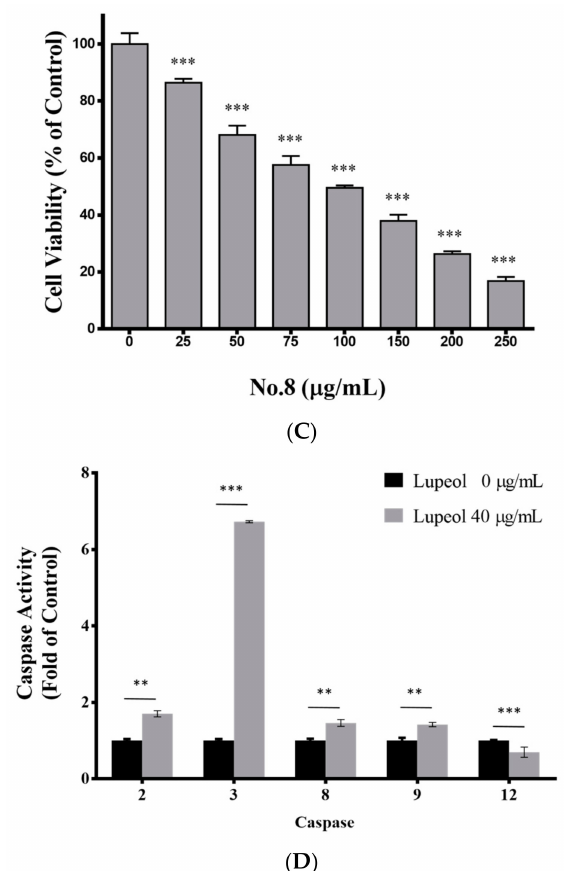
Figure 2. Apoptotic effect induced by AVL ( Apocynum venetum L.) F8 and lupeol on PC3 cells. ( A ) DAPI (4 (cid:48) ,6-diamidino-2-phenylindole) staining of AVL No. 8 or lupeol-treated PC3 cells; ( B ) flow cytometric analysis of propidium iodide staining was used to analyze apoptosis in PC3 cells following vehicle-treatment and 50, 100 µ g/mL for 24 h; ( C ) PC3 cells were treated with F8 at designated concentrations for 24 h. Cell viability was determined by MTT (3-(4,5-Dimethylthiazol-2-yl)-2,5-diphenyltetrazolium bromide) assay; and ( D ) lupeol-induced caspase activation in PC-3 cells. All data are expressed as the means ± standard deviation (SD) of at least three replicates ( n ≥ 3). Statistical significance was calculated by comparing with control group. ** p < 0.05; *** p <